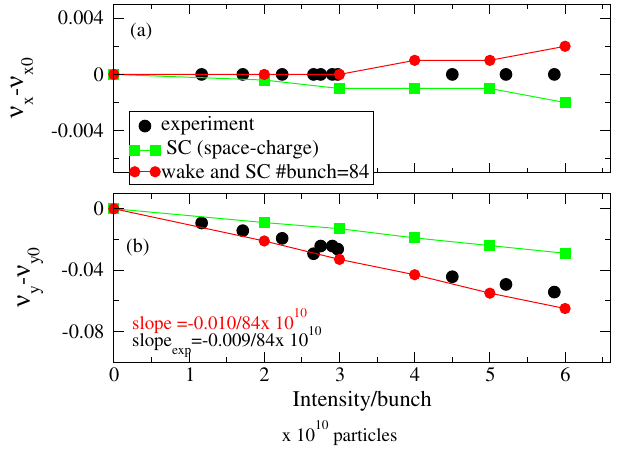
FIG. 9. Coherent horizontal (a) and vertical (b) tune shift versus beam intensity. The estimated tune uncertainty in calcu- lations is less than 0.001. The vertical tune is decreased while the horizontal tune changes very little. Space charge impedance (SC) decreases both the vertical and horizontal tunes, while the wake decreases the vertical tune and increases the horizontal tune. The calculation are in good agreement with the experiment, the deviation being within 3 (cid:8) meas